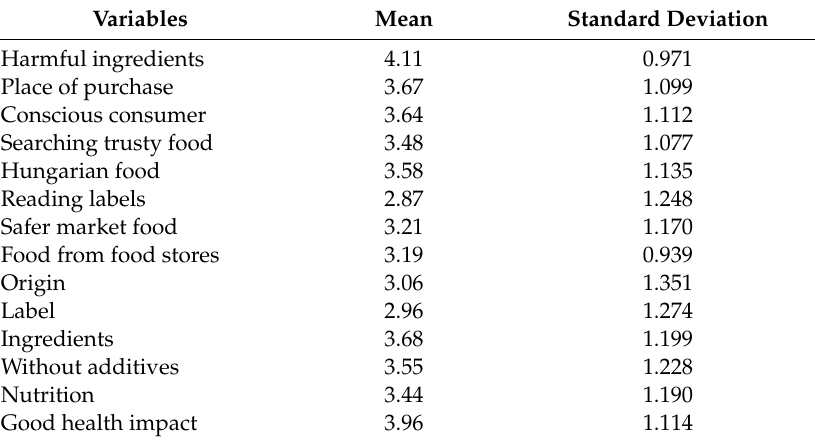
Table 1. Variables used for segmentation.